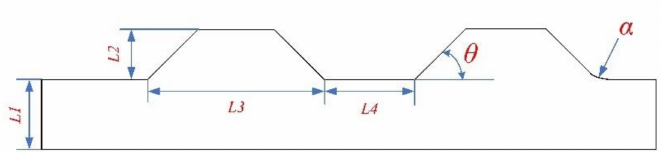
Figure 3. Dimension definitions of the TS of